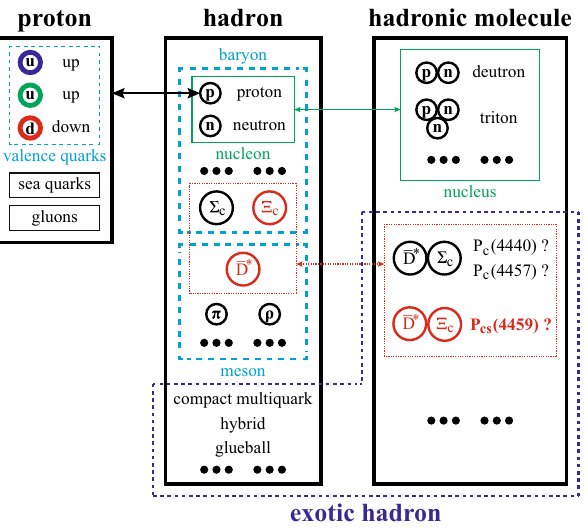
Fig. 1 A possible way to construct the subatomic world